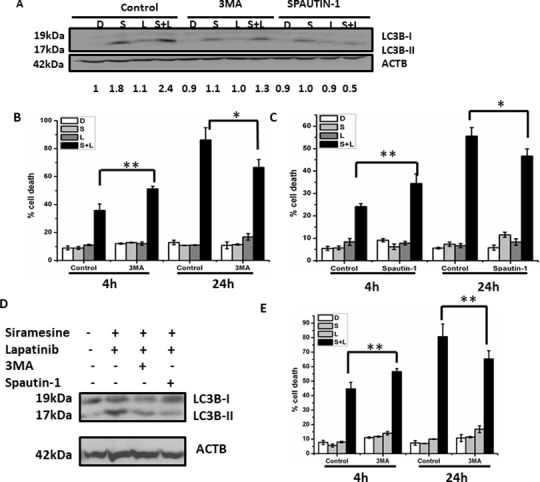
Autophagy inhibitors increase cell death at an early time of siramesine and lapatinib treatment but inhibit cell death at a later time.(A) Inhibition of autophagy by autophagy inhibitors 3-methyladenine (3-MA, 2 mM, and same hereafter) and spautin-1 (3 microM, and same hereafter) under siramesine and lapatinib treatment as demonstrated by LC3-II western blot in MDA MB 231 cells. (B) The effects of 3-MA on cell death under siramesine and lapatinib treatment in MDA MB 231 cells for 4 and 24 hours. (C) The effects of spautin-1 on cell death under siramesine and lapatinib treatment in MDA MB 231 for 4 and 24 hours. Cell death was quantified by flow cytometry as described in the Materials and Methods section (and same hereafter). Before treatment with siramesine and lapatinib, cells were pretreated with 3-MA or spautin-1 for 1 hour (and same hereafter). (D) Inhibition of autophagy by autophagy inhibitors 3-methyladenine (3-MA, 2 mM) and spautin-1 (3 microM) under siramesine and lapatinib treatment as demonstrated by LC3-II western blot in SKBR3 cells. (E) The effects of 3-MA on cell death under siramesine and lapatinib treatment in SKBR3 cells for 4 and 24 hours. These results were representative of three independent experiments (n = 3). *p<0.05; **p<0.01.